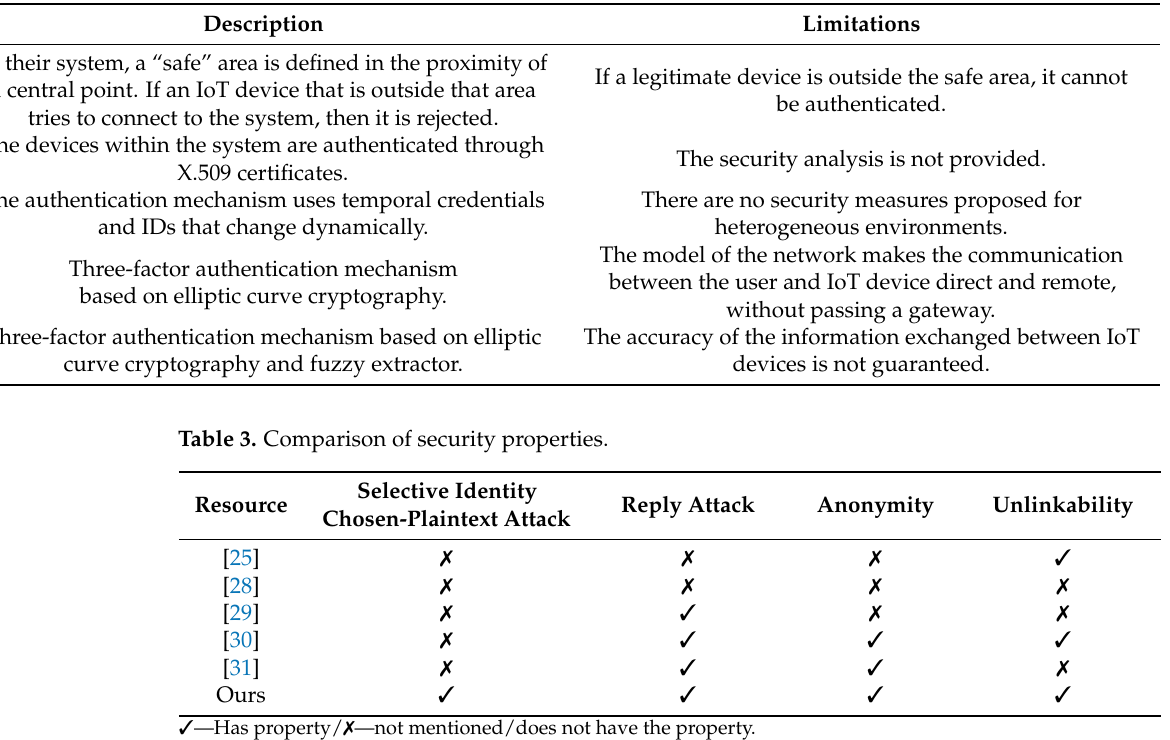
Table 2. Summary of related work.